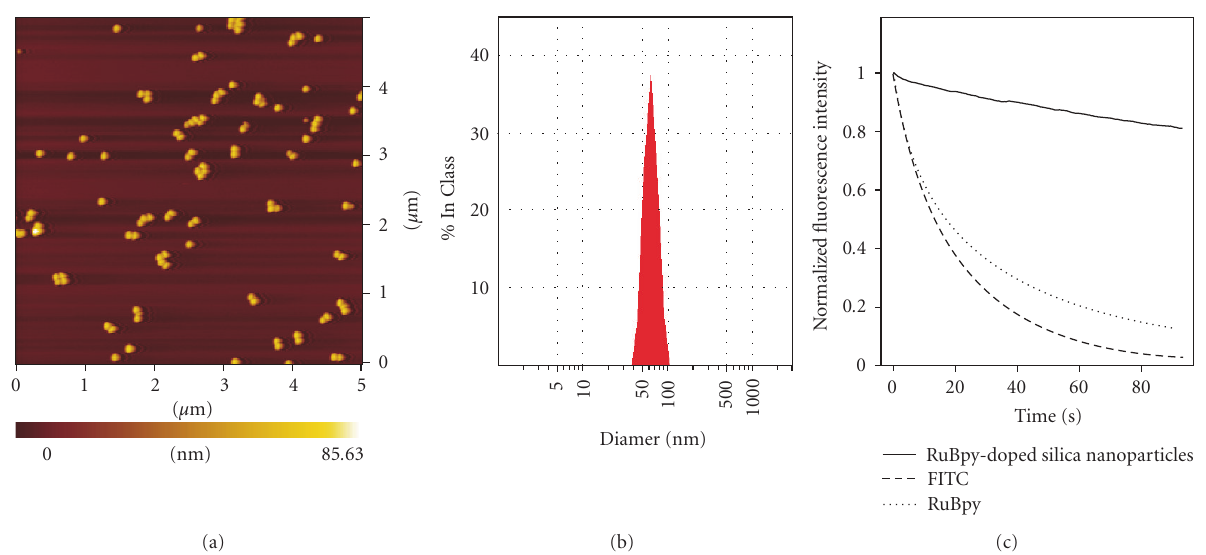
Figure 1: Properties of RuBpy-doped silica nanoparticles. (a) AFM micrograph of the RuBpy-doped silica nanoparticles. Particle size is determined to be 65 ± 2 nm. (b) Size distribution analysis of RuBpy-doped silica nanoparticles in water by dynamic light scattering (DLS). The volume-weighted average diameter determined is 63.8 nm. (c) Photostability of RuBpy-doped silica nanoparticles versus pure RuBpy dye molecules and FITC dye molecules. Realtime measurements of fluorescence intensities were performed on an confocal microscope with an intensive argon/krypton laser as the excitaton source.